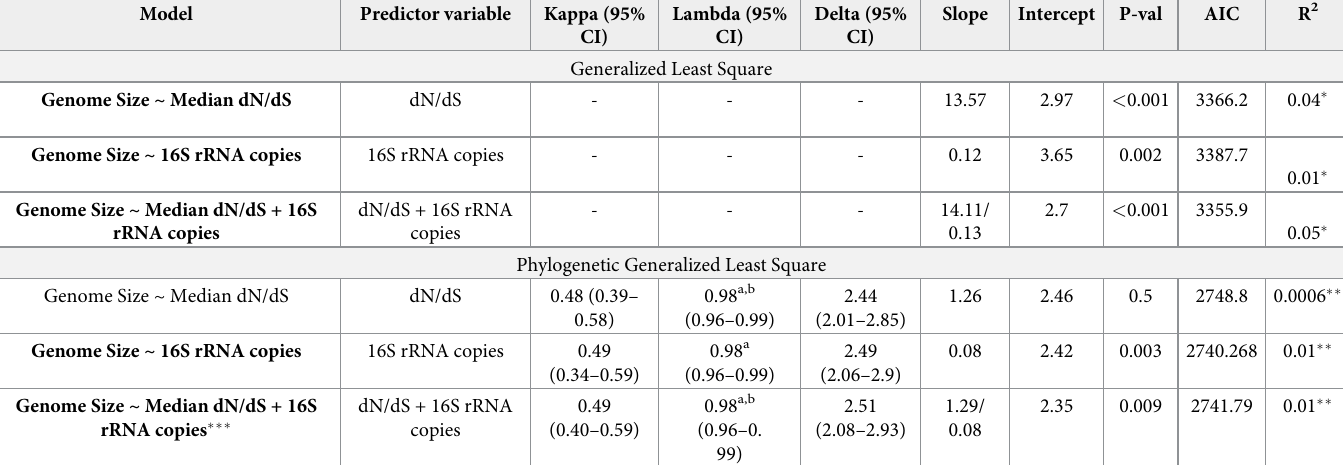
Table 2. Statistics of the regression models relating genome size with dN/dS and 16S rRNA as predictor variables using Generalized Least Square and Phylogenetic Least Square analyses. We highlighted the models that were statistically significant ( α =